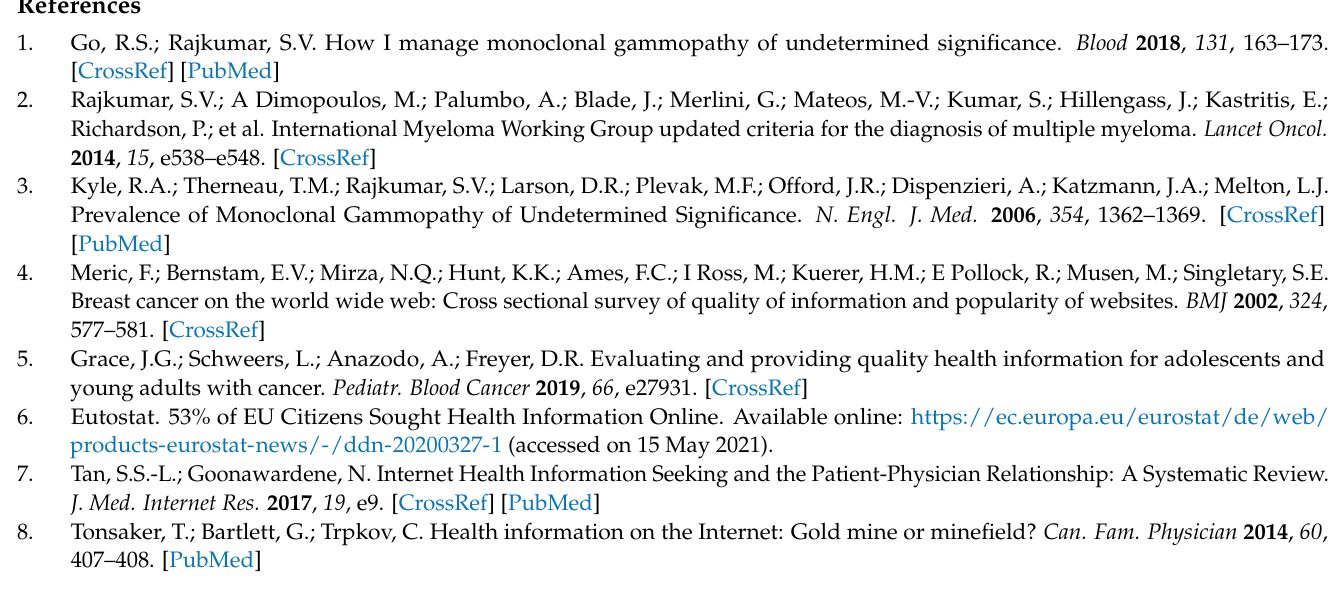
last update, Figure S2: Characterization of websites by category, Figure S3: Characterization of videos by category, Table S1: Scores, measures and certificates used for the evaluation of websites and videos, Table S2: Website and video content evaluation by MGUS key facts, Table S3: Characterization of websites by search engine, Table S4: DISCERN score for websites and videos, Table S5: Website data, Table S6: Video